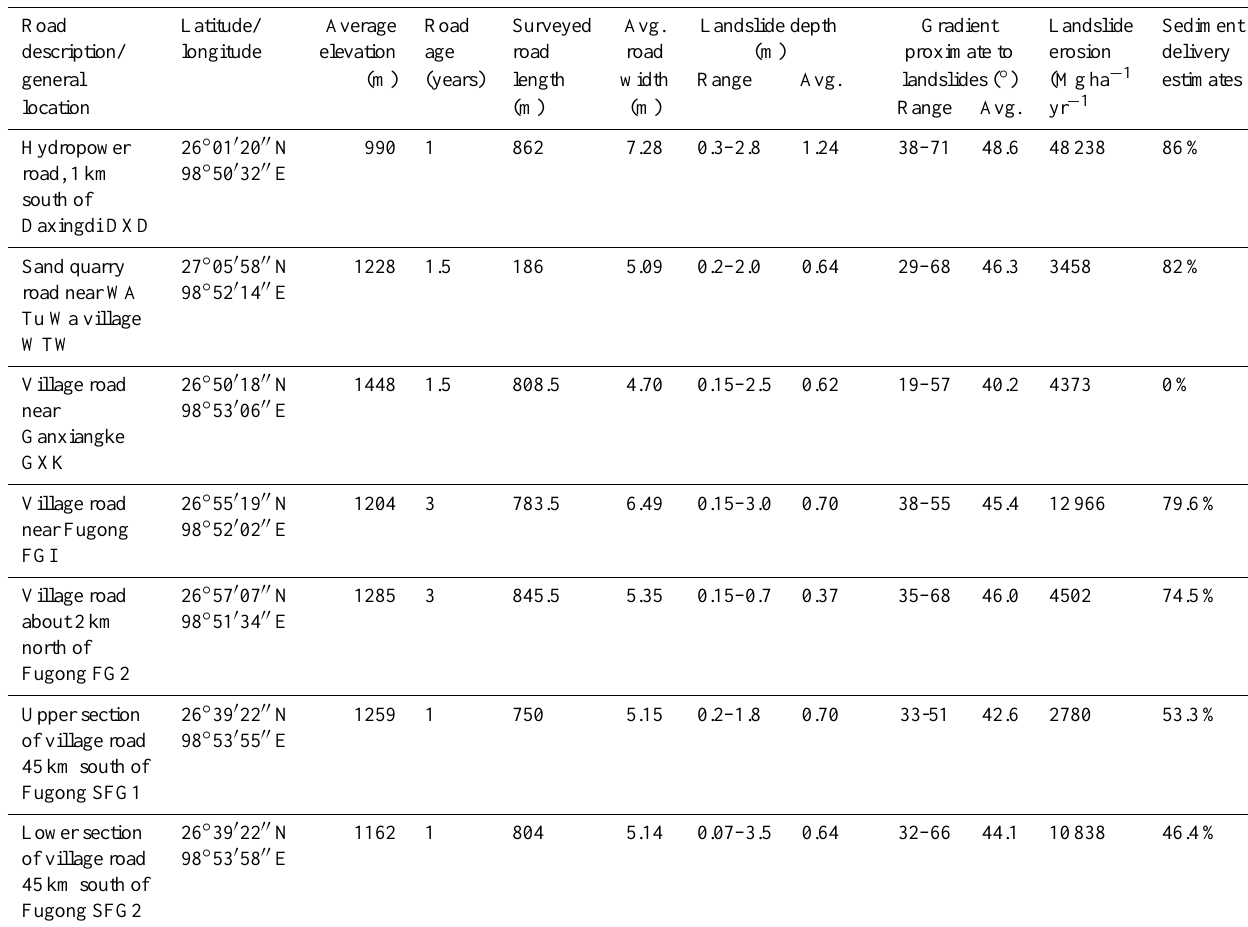
Table 1. Geographic information and landslide erosion data for the seven road segments surveyed in northwestern Yunnan.